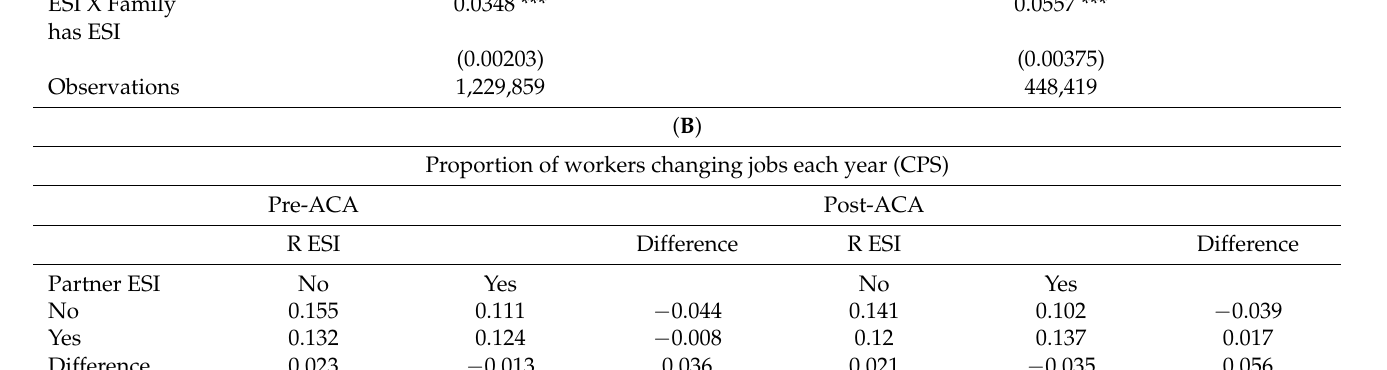
Table 4. ( A ) Difference-in-Differences Estimates of Partner ESI on Job Mobility. CPS Analyses. ( B ) DD using Partner’s Insurance as Cost Factor .